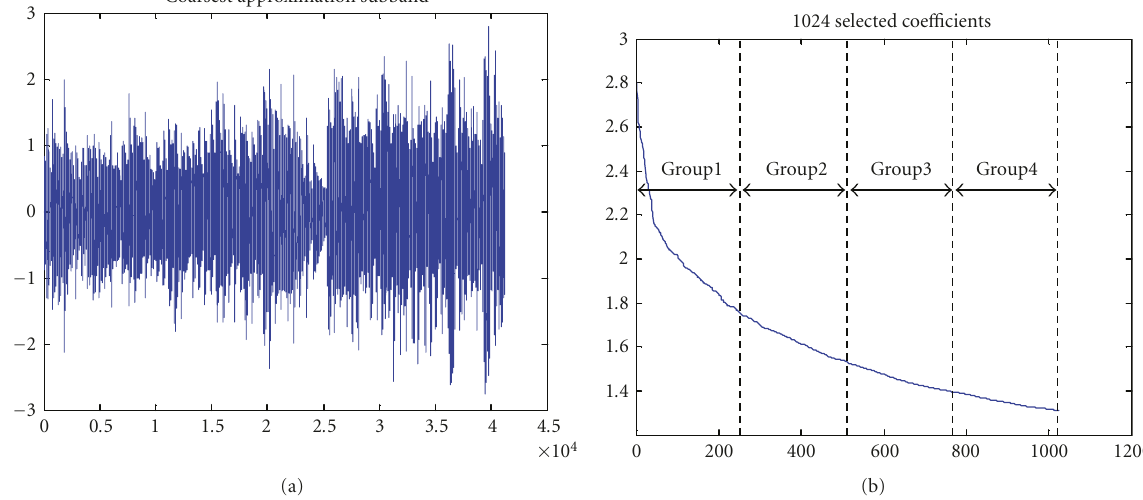
Figure 3: (a) The coarsest approximation subband of five-level multiwavelet decomposition and (b) the 4 groups of the first N w (1024) largest coe ffi